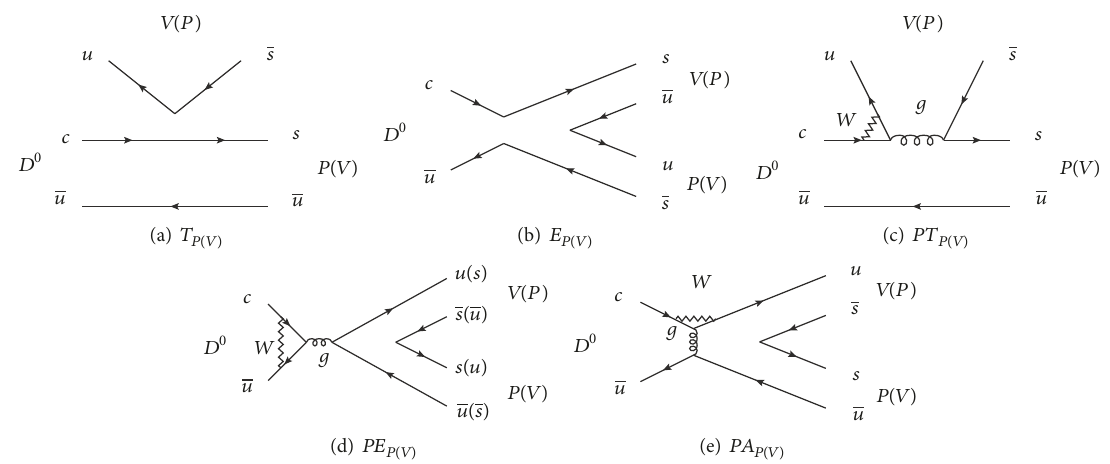
𝑃𝑇 𝑃(𝑉) , (d) the gluon-annihilation penguin amplitude